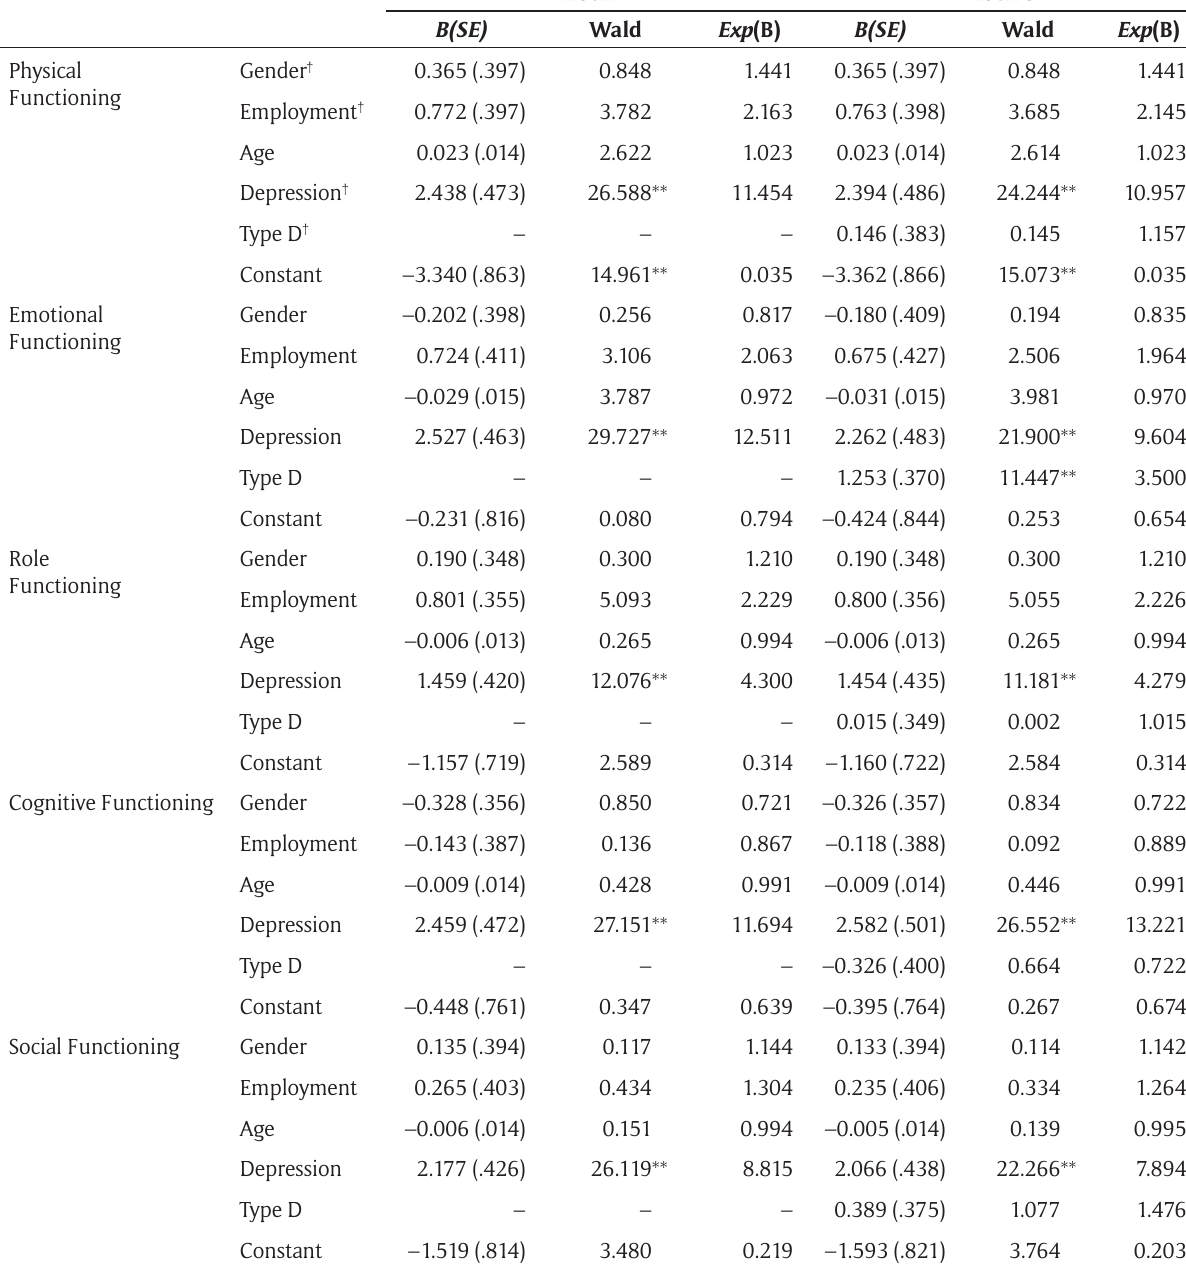
Table 3: Predictor statistic results with depression and Type D as categorical